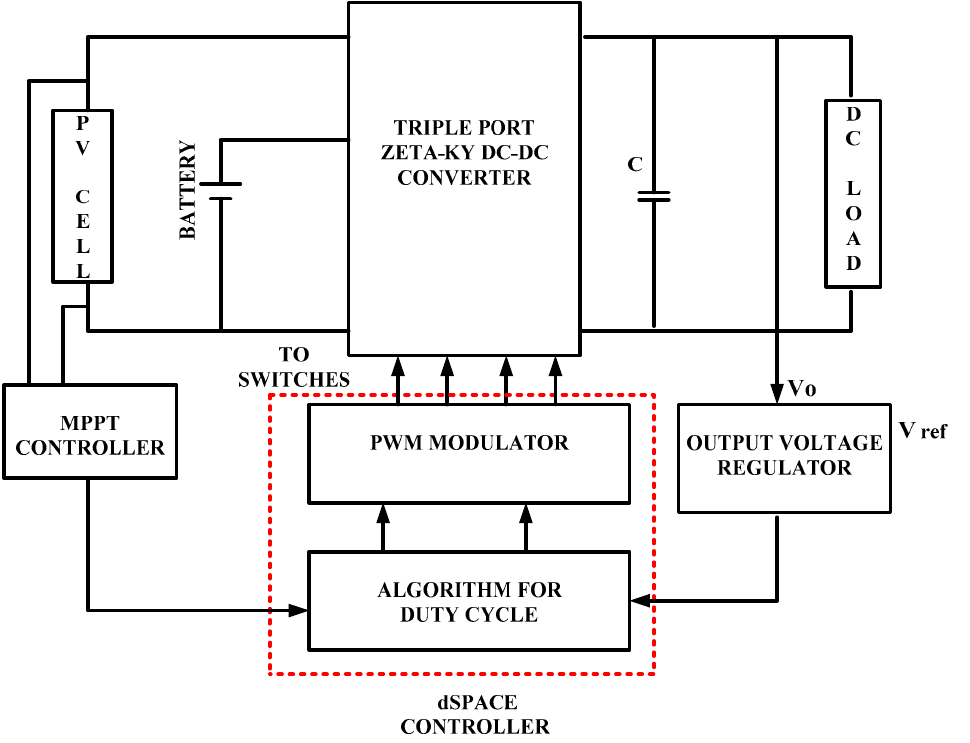
Figure 2. Control architecture of the proposed triple port Zeta-KY converter.